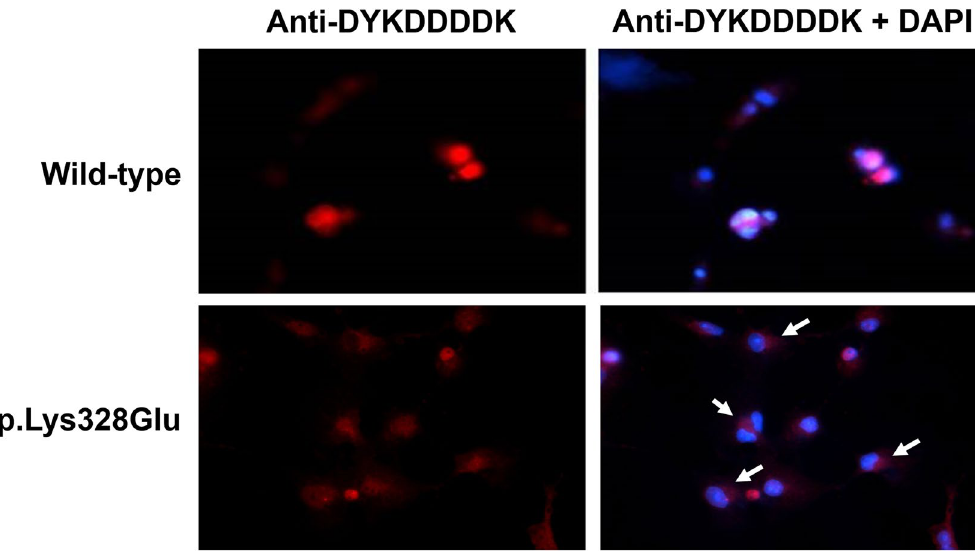
Figure 3. The POU4F3 c.982A > G mutation altered the subcellular localization of transcription factor POU4F3. Nuclei stained with DAPI (blue) and POU4F3 detected by Anti-DYKDDDDK-Tag antibody (red) were visualized by confocal microscopy. The white arrows indicate POU4F3 outside the